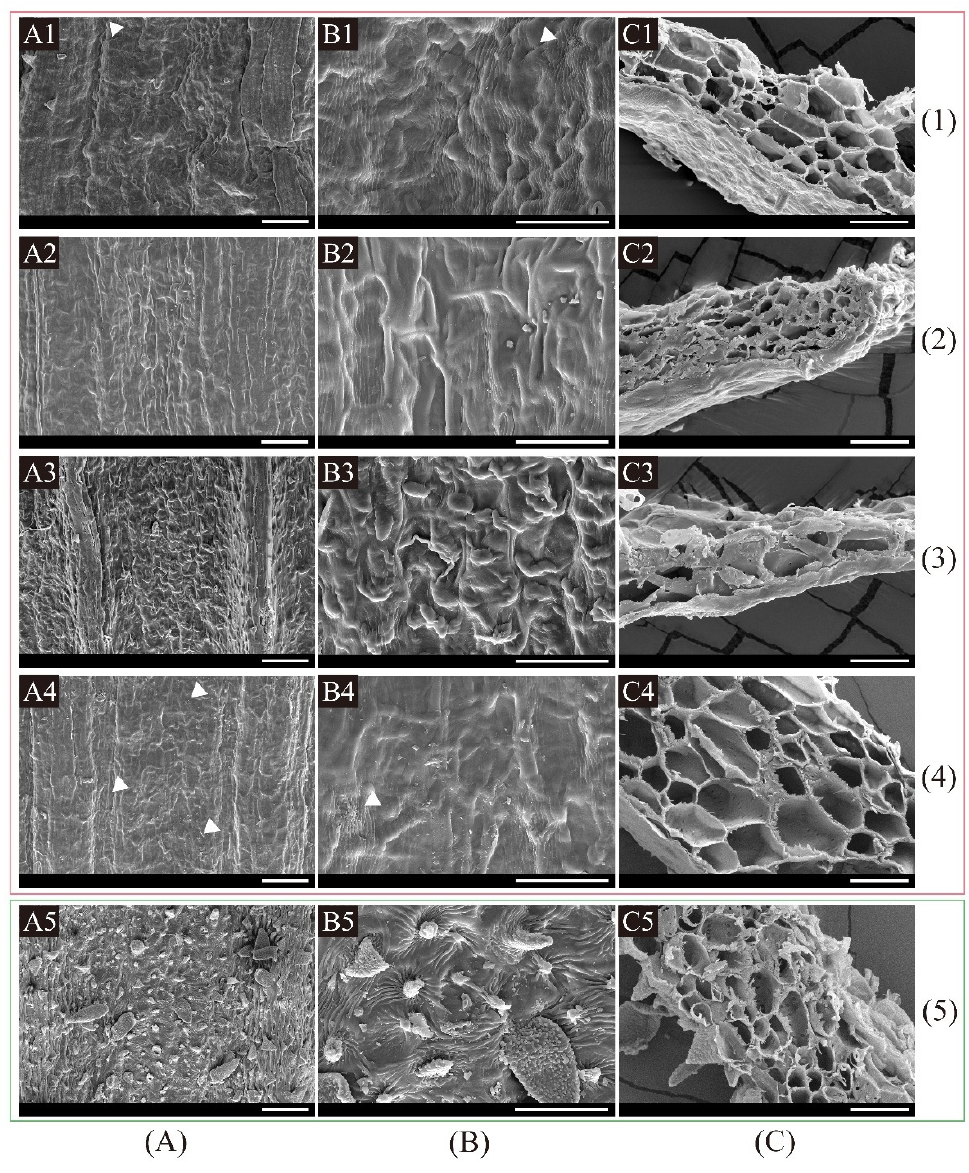
Figure 6. Fruit micromorphological characteristics of five Kitagawia species. ( A ) surface patterns of fruits; ( B ) cuticular foldings of fruit surfaces; ( C ) inner structure in marginal ribs of fruits. ( 1 ) K. baicalensis ; ( 2 ) K. stepposa ; ( 3 ) K. komarovii ; ( 4 ) K. terebinthacea ; ( 5 ) K. praeruptora . Rugulate cuticles are marked with white triangles. Boxes in pink and green are for Subclade I and Subclade II, respectively. Scale bar = 100 µm in ( A ); 50 µm in ( B , C ).